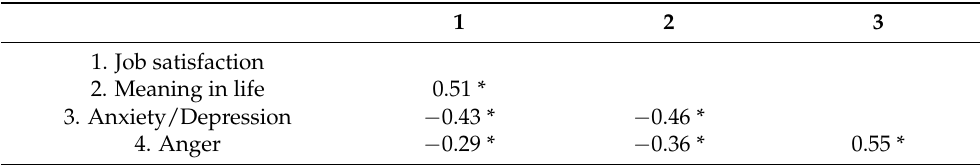
Table 1. Zero-Order correlations between job satisfaction, meaning in life, anxiety/depression symptoms, and anger.